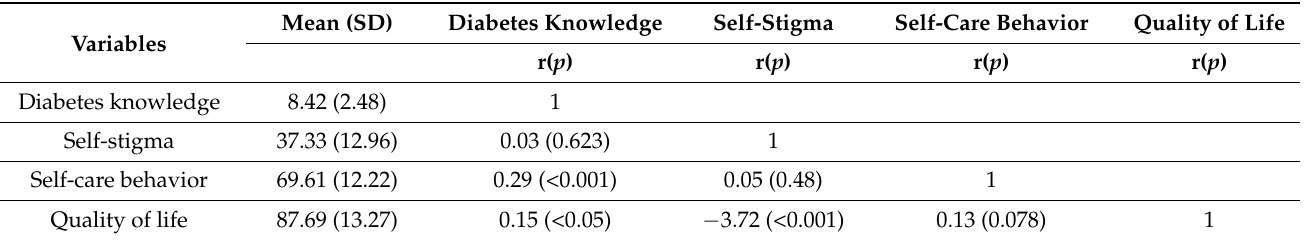
Table 3. Means, standard deviations and correlations between variables. ( n =